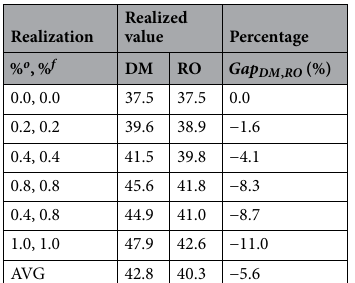
Table 8. Average realized values under high demand and perturbation set ( ˆ µ o = 80, ˆ µ f = 160 )